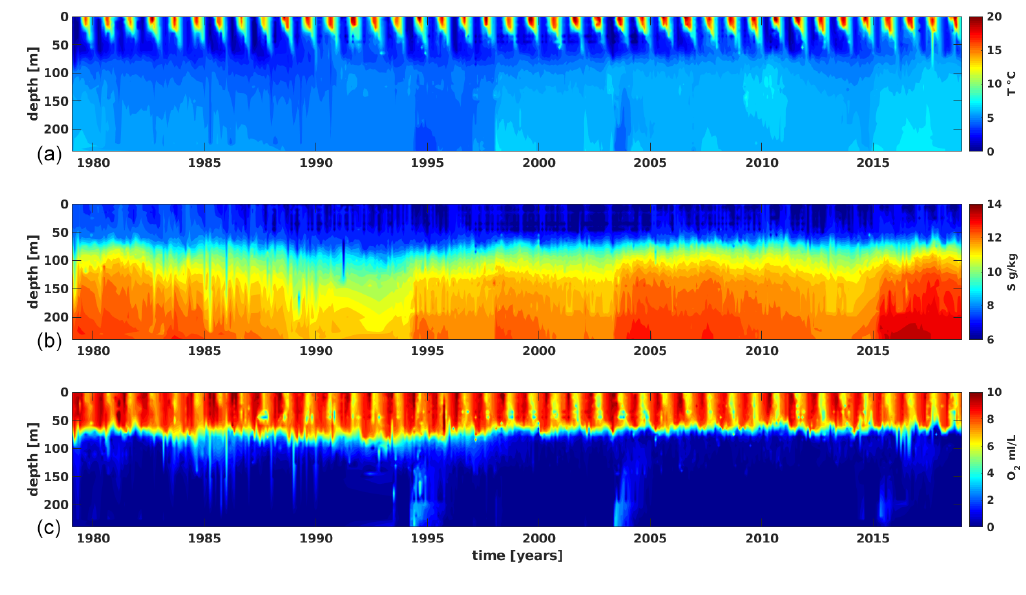
Figure 2. Observed temperature (a) , salinity (b) , and oxygen (c) data as a function of depth and time. Subdivision 28 (SD 28, eastern Gotland Basin) for the period 1979–2018. Data from the ICES Marine Data Centre (https://www.ices.dk/Pages/default.aspx, last access: 12 August 2019).